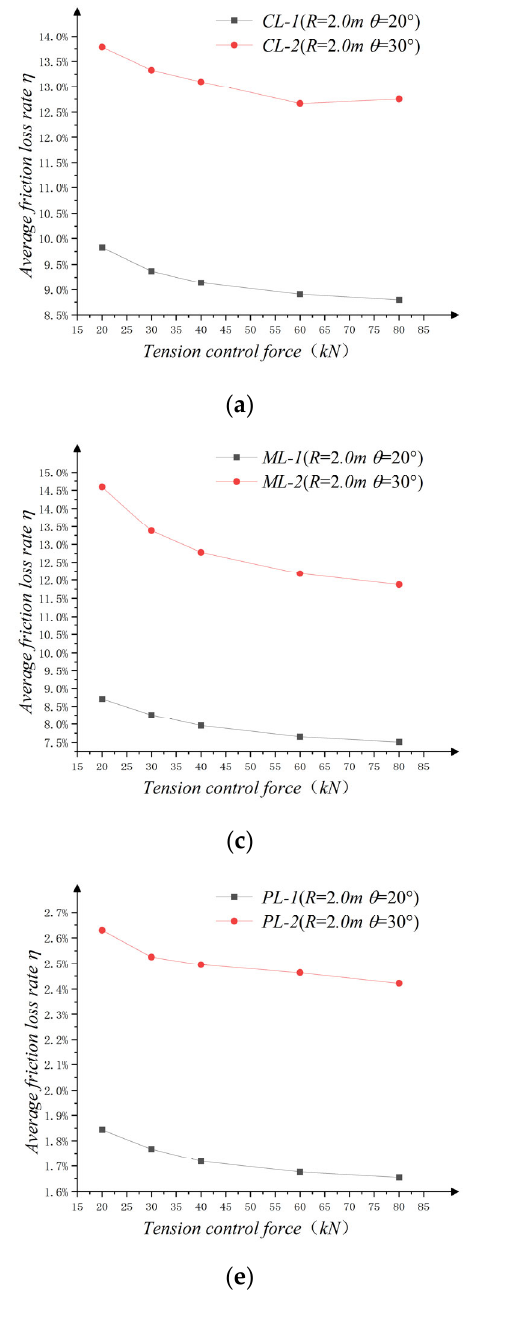
Figure 8. Comparison of data with different steering radius θ only:( a ) comparison group of CL ‐ 1 and CL ‐ 2; ( b ) comparison group of CL ‐ 3 and CL ‐ 4; ( c ) comparison group of ML ‐ 1 and ML ‐ 2; ( d ) comparison group of ML ‐ 3 and ML ‐ 4; ( e ) comparison group of PL ‐ 1 and PL ‐ 2; ( f ) comparison group of PL ‐ 3 and PL ‐ 4.